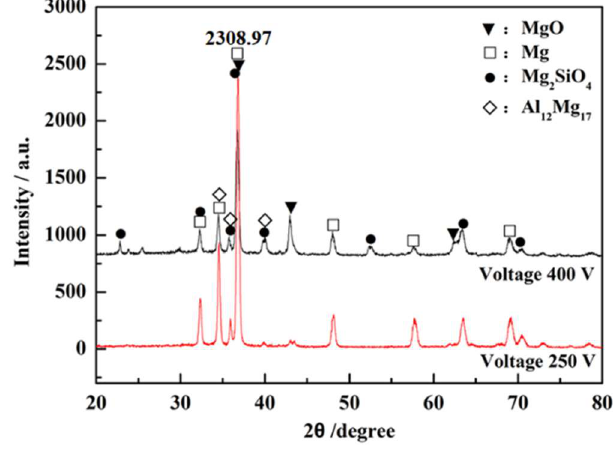
Figure 4. XRD patterns for the coatings with voltage at 250 V and 400 V.